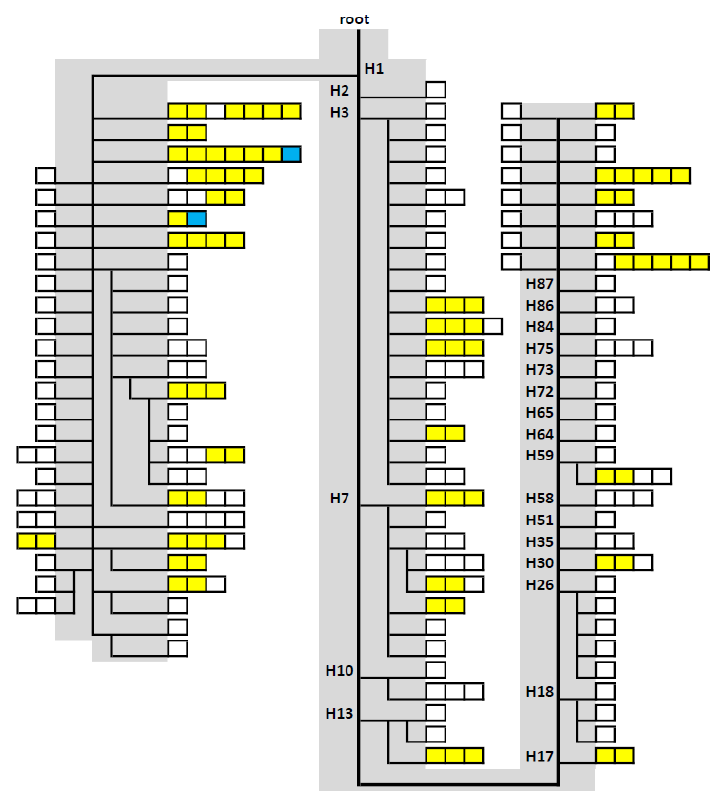
Figure 1. Schematic phylogenetic tree of the 216 mitogenomes sharing the most common West Eurasian CR haplotype motif. The tree is rooted in haplogroup H. The gray backbone and clade names follow PhyloTree mt Build 17. Every box represents a mitogenome. Adjacent yellow boxes indicate identical mitogenomes. White boxes stand for unique mitogenomes. The blue boxes indicate UniPV_046, which matches two haplotypes with one and six representatives. Stem lengths have no information content (see text and Figure S1 for details).